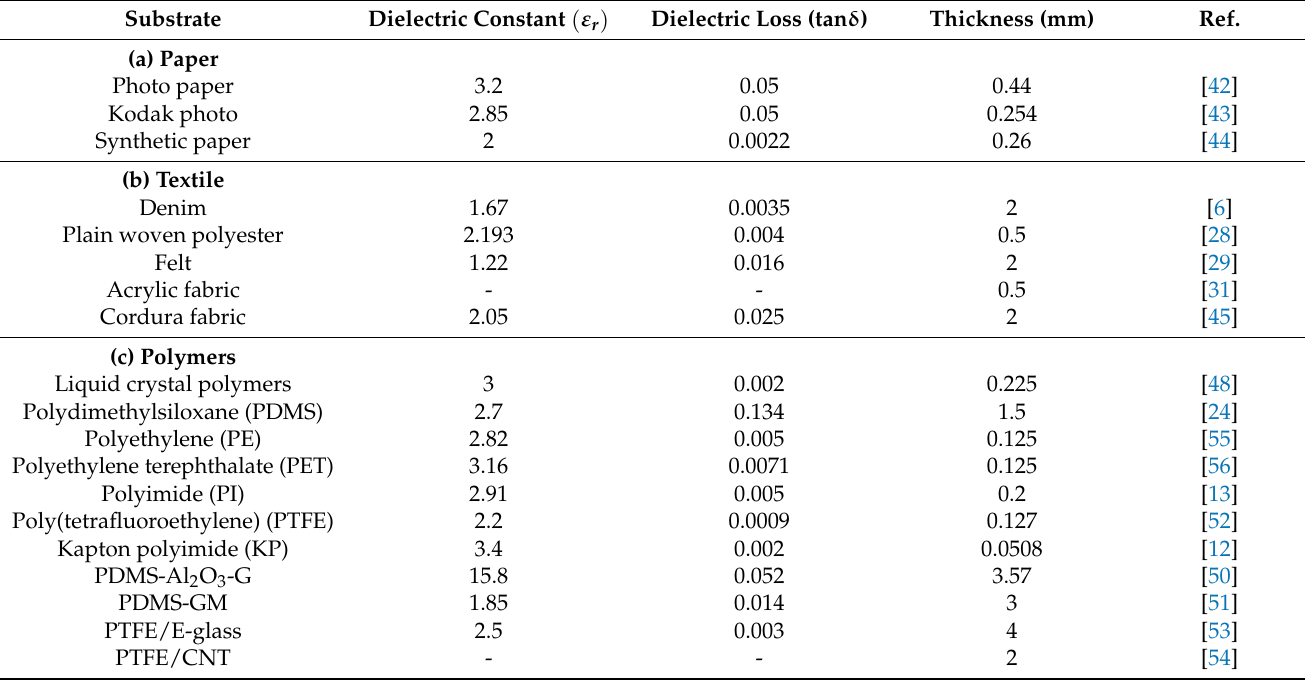
Table 2. Comparison of various substrate materials in flexible antenna